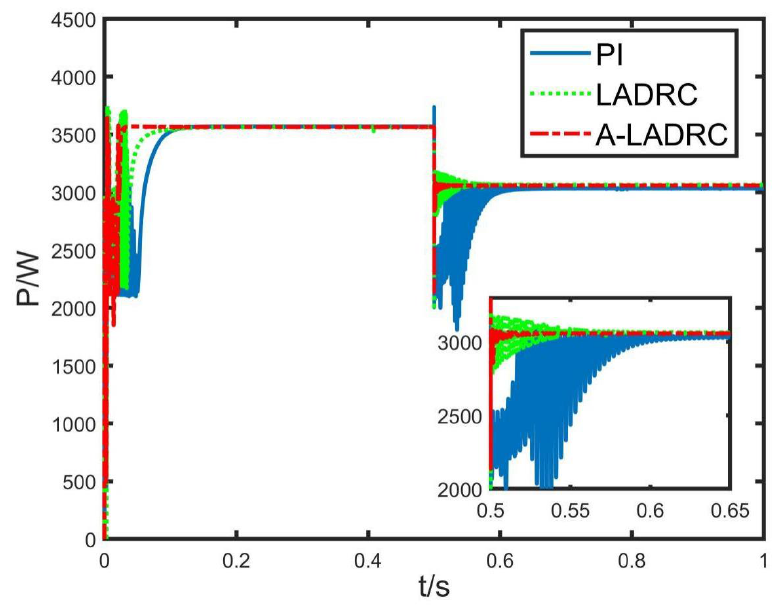
Figure 14. Photovoltaic array output power by changing PV1 light intensity.